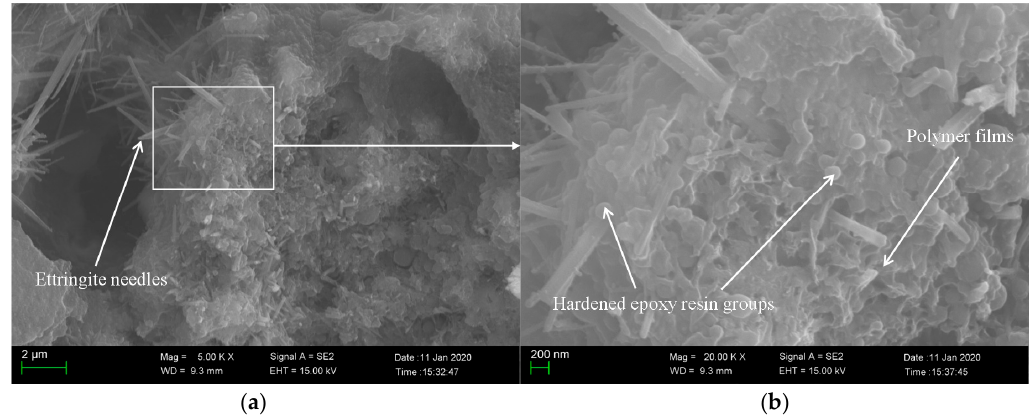
Figure 13. SEM image of fractured sections of epoxy latexes modified cement mortar under wet–dry curing regimes with the addition of 15% epoxy resin at 45 d: ( a ) 5000× and ( b ) 20,000×.